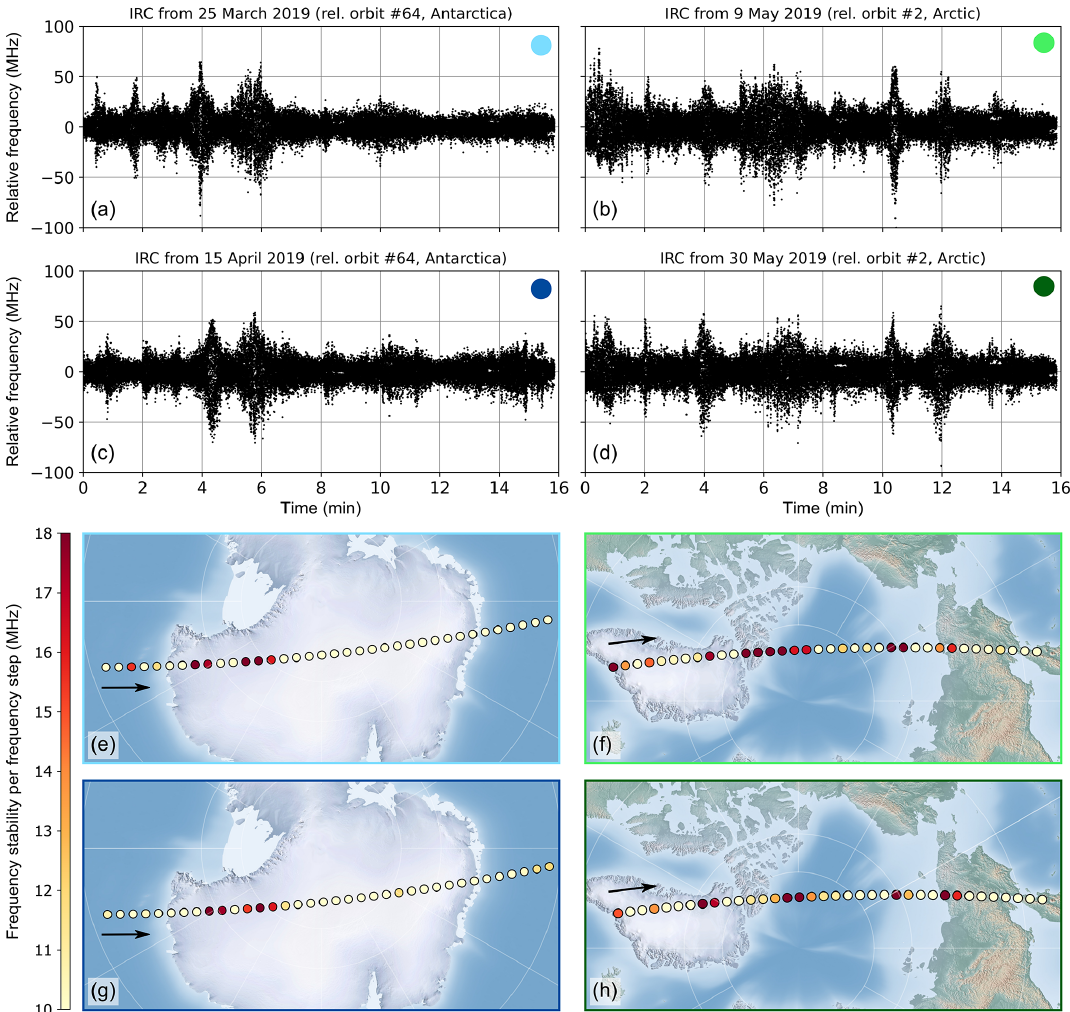
Figure 5. Time series of the laser frequency fluctuations over periods of selected IRCs over Antarctica (a, c) and the Arctic (b, d) together with the corresponding geolocations of the individual frequency steps in panels (e) – (h) . Each dot corresponds to one frequency step (24s), whereby the color coding describes the standard deviation of the relative frequency on the pulse-to-pulse level within this period ( σ f (N = 1080 ) ).